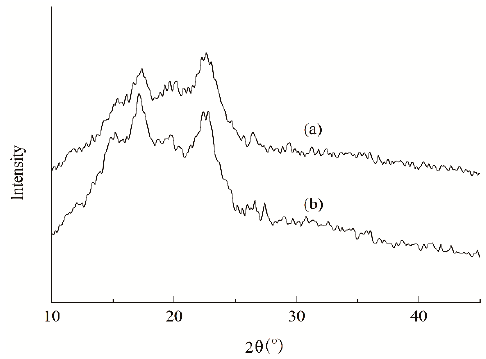
Figure 9. X-ray diffractograms of the HCS (a) and ACS (b) films. Figure 9. X-ray di ff ractograms of the HCS (a) and ACS (b)